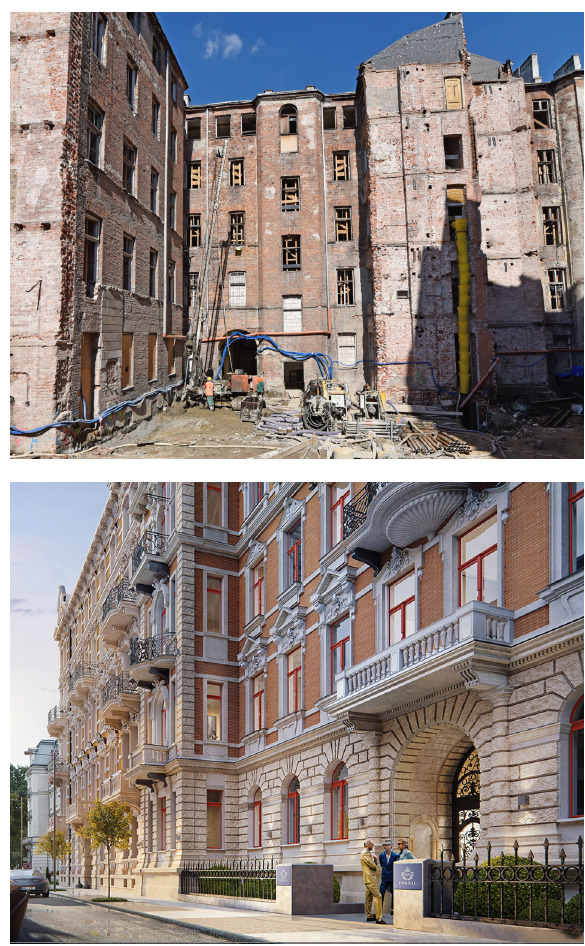
Figure 1. Historical building Foksal 13 before (top) and after (bottom)